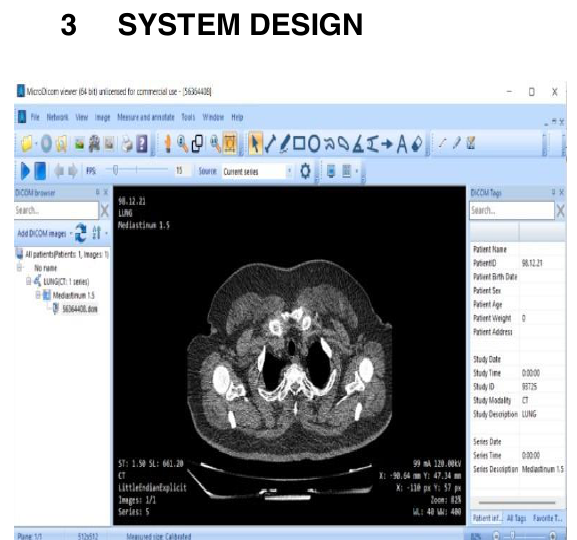
Figure 3.1: Micro-DICOM Viewer Sample Dataset of a patient’s lungs diagnosed with COVID-19